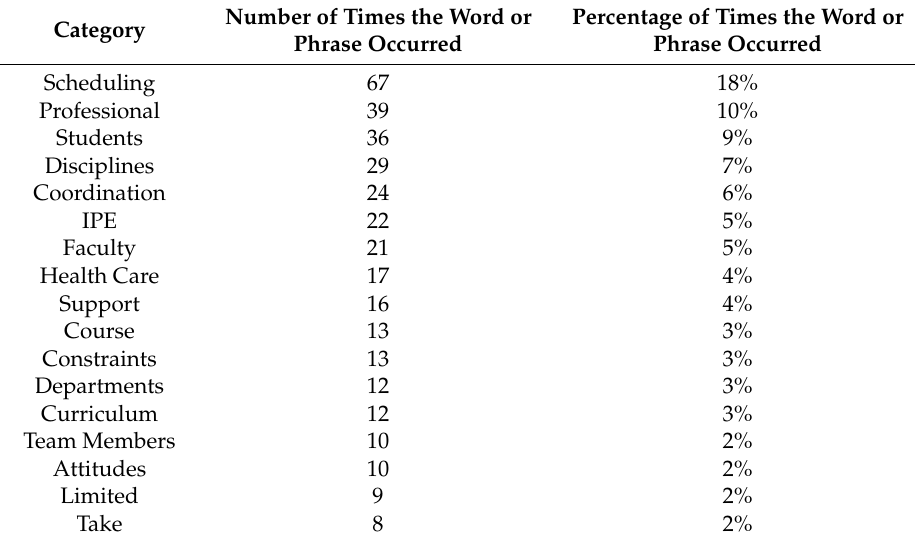
Table 2. Negative factor